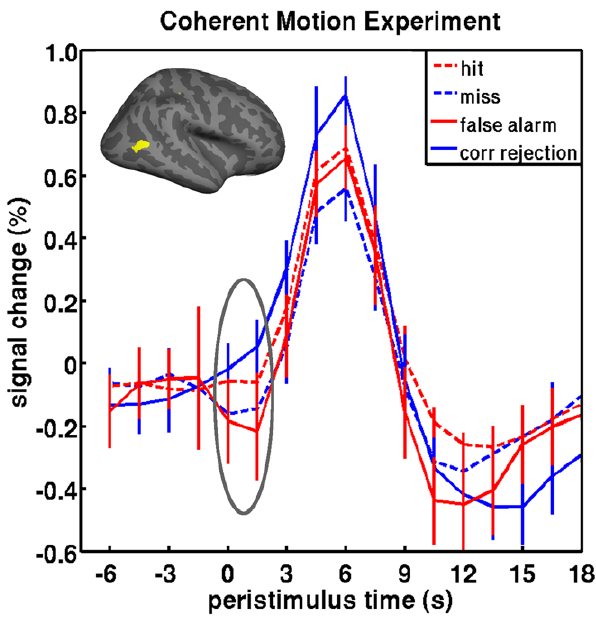
Figure 1. Peristimulus fMRI signal time-courses from the visual motion experiment. Data were normalized to grand mean and averaged across 9 subjects (bars represent standard error of the mean) performing a motion coherence judgment task. The insert specifies the conditions as a function of stimulus and percept. The inflated right hemisphere rendering of the group result shows the right hMT + region of interest, which was identified subject by subject in a localizer procedure employing coherent motion stimuli vs. static displays. The grey ellipse covers the pre-stimulus period submitted to statistical testing (see main